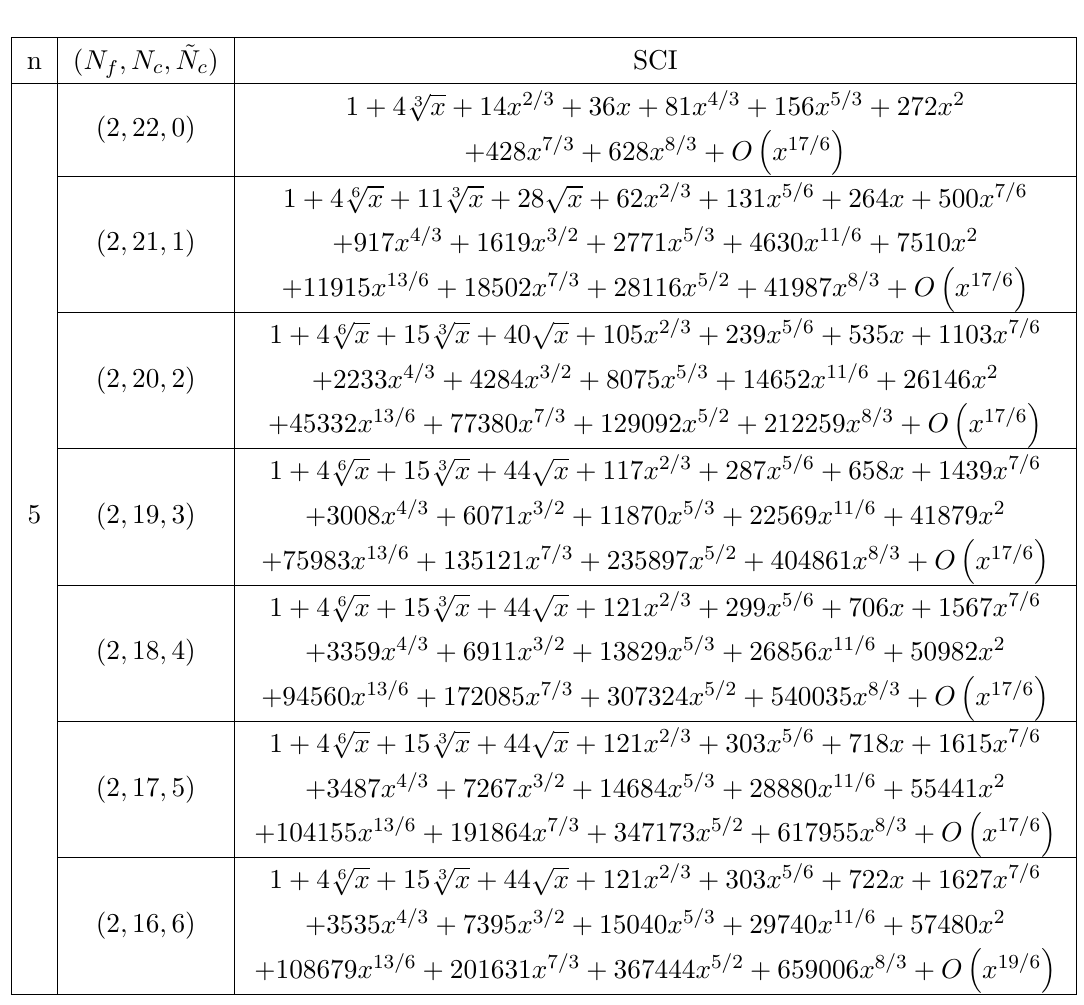
+ W − . 0 0 ) = (5 , 2) and f ) SU( N ) flavor f t × f u